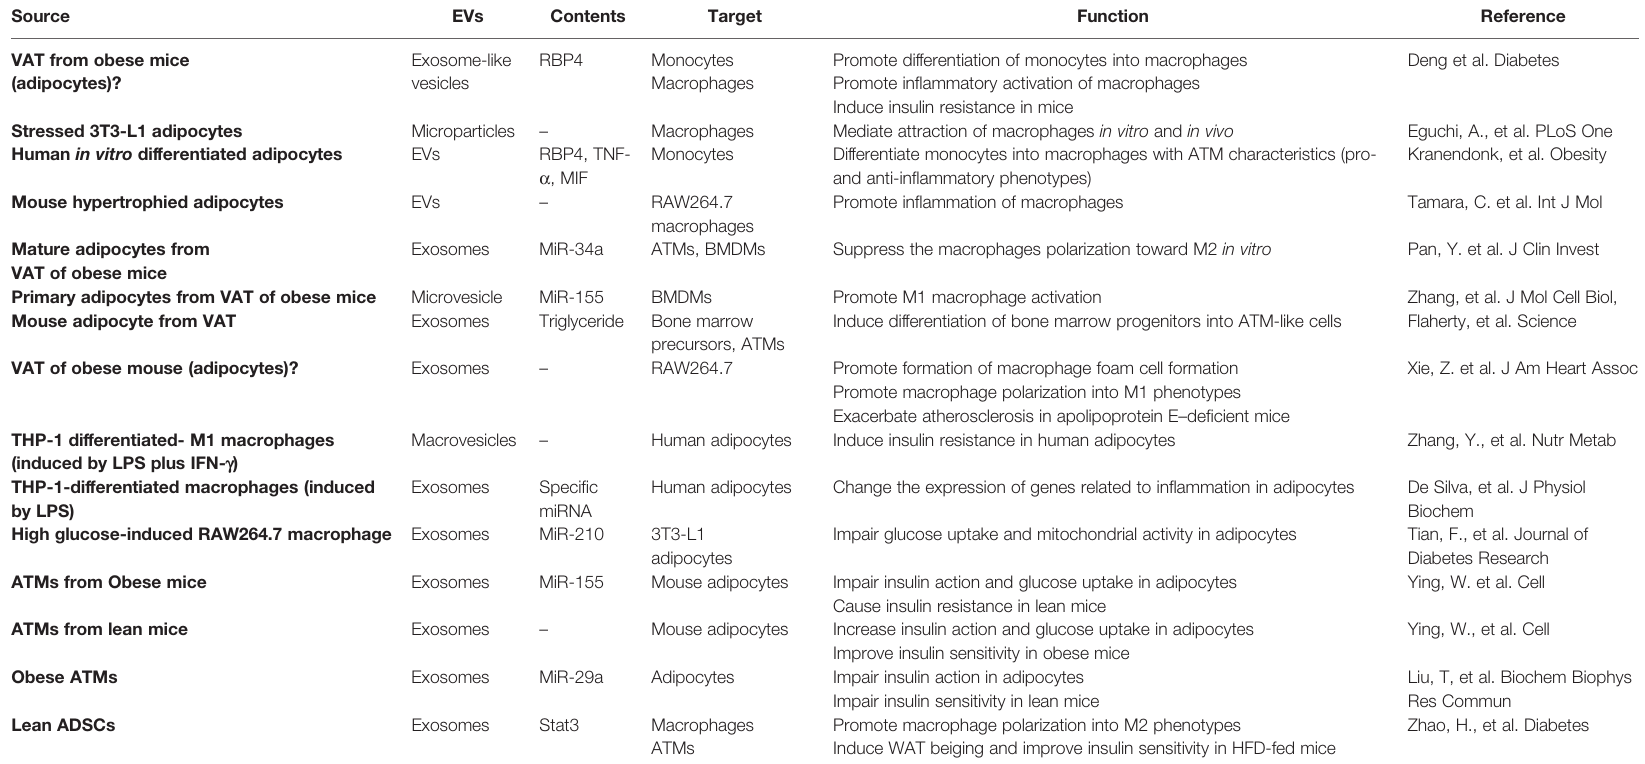
TABLE 1 | EVs involved in adipocyte-macrophage dialogue and ADSC-macrophage